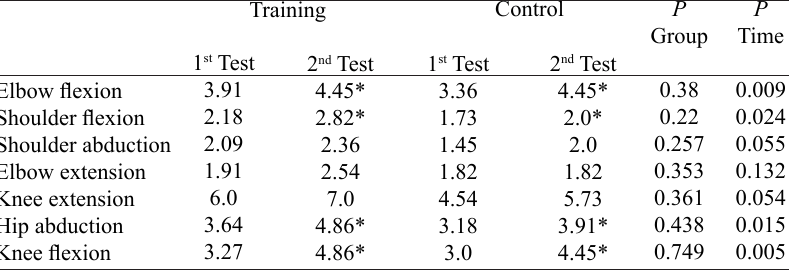
Table 4. Test of 1RM values before and after implementation of the training programs